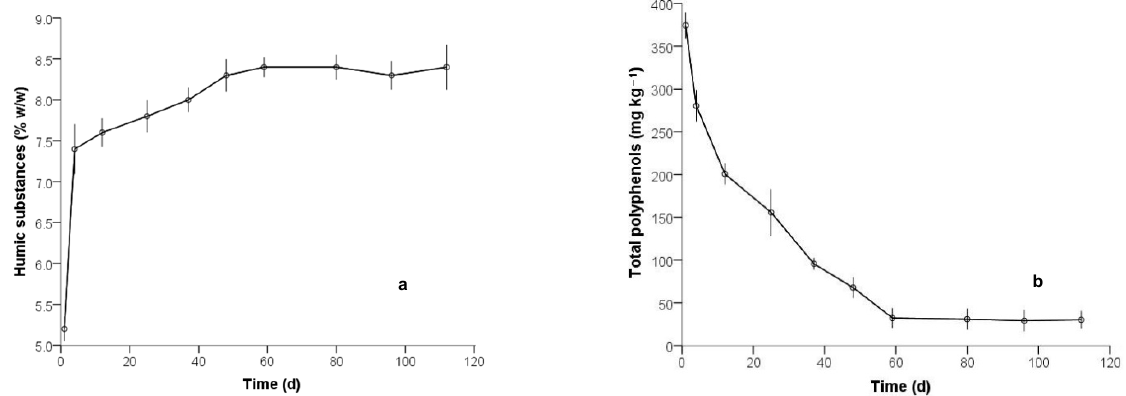
Figure 5. Humic substances ( a ) and polyphenols content ( b ) variation with time during bioremediation. Error bars were placed at the 95% confidence level.